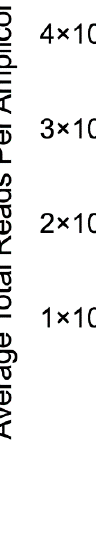
Figure 1. Total yield of cfDNA per patient for stage III vs. stage IV melanoma patients. Mann– Whitney, unpaired, nonparametric t -test was performed.